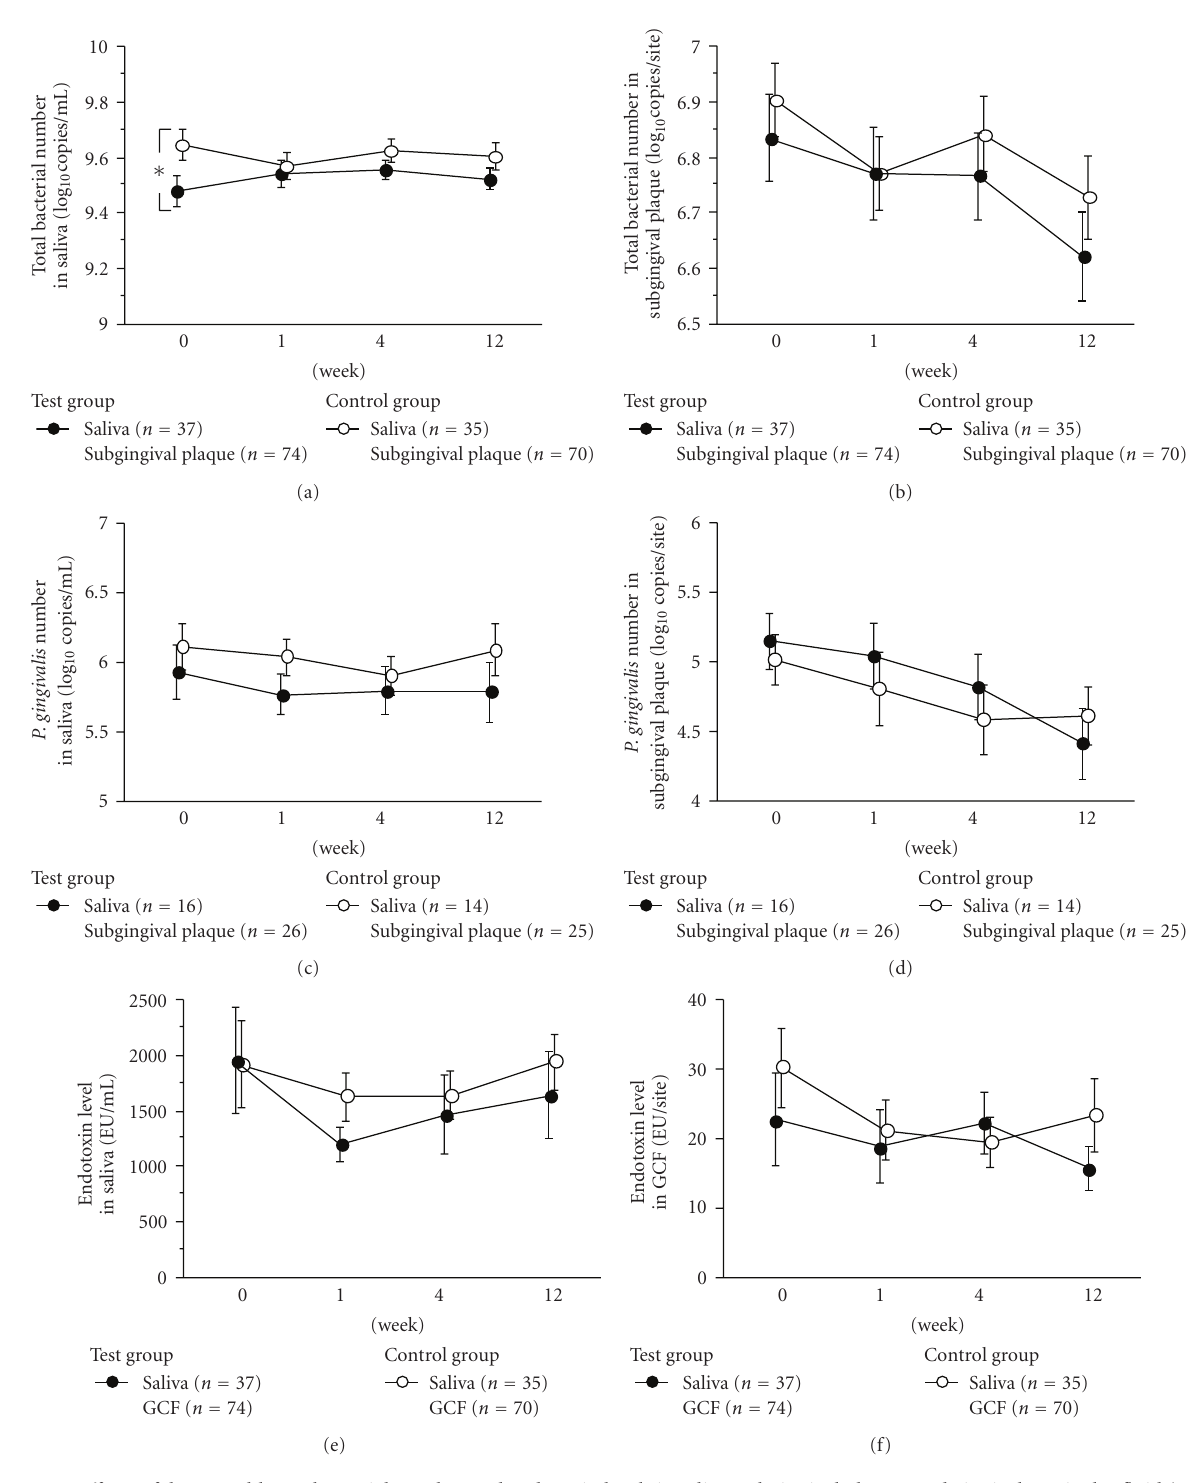
Figure 3: E ff ects of the test tablet on bacterial number and endotoxin levels in saliva, subgingival plaque, and gingival crevicular fluid (GCF). Total bacterial number in saliva (a), total bacterial number in subgingival plaque (b), P. gingivalis number in saliva (c), P. gingivalis number in subgingival plaque (d), saliva levels of endotoxin (e), and GCF levels of endotoxin (f) were measured at baseline, 1W, 4 W, 12W. Values represent the mean ± standard error. The number of total bacteria and P. gingivalis in subgingival plaque and GCF levels of endotoxin were assessed in two teeth with chronic periodontitis per subject. ∗ Significant di ff erence between the test and control groups, as identified by Student’s t -test ( P < .